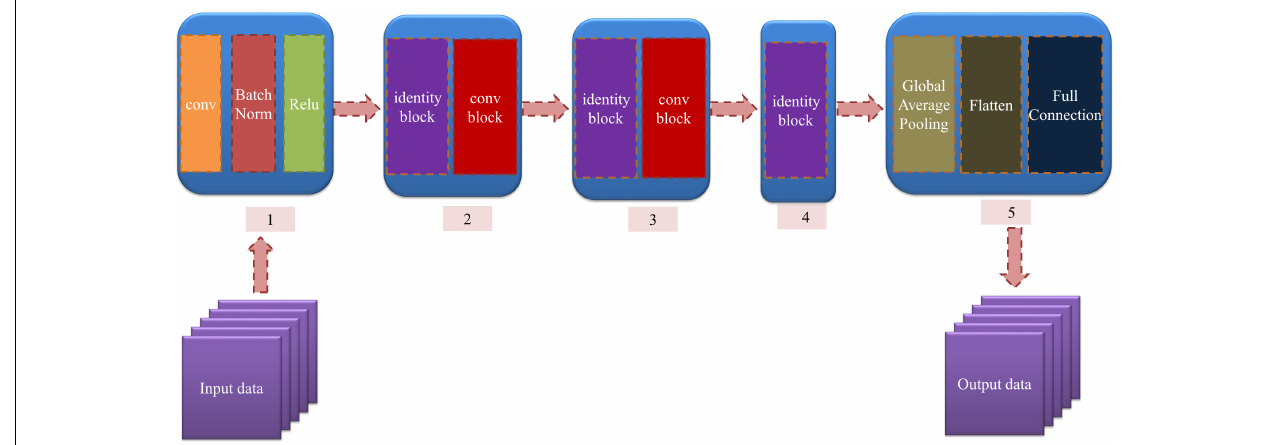
FIGURE 2 | The structure of the ResNet